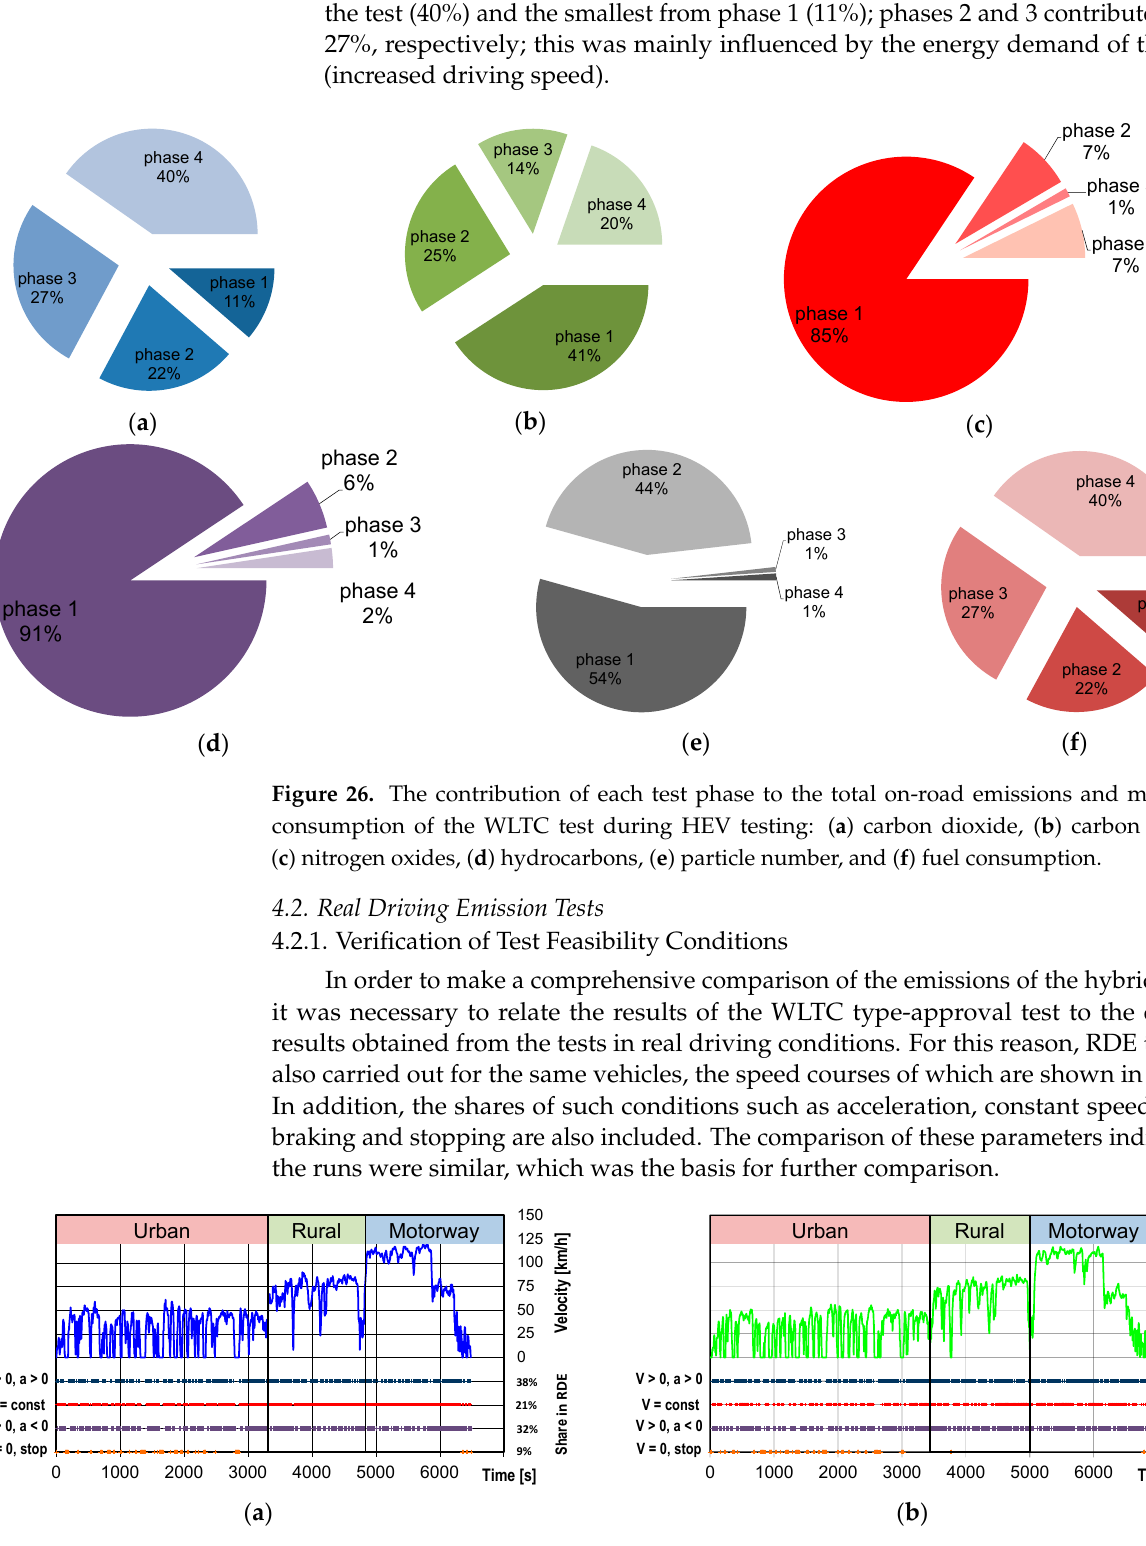
Figure 27. The scheduled velocity of vehicle during the real driving emissions test for: ( a ) plug-in; ( b ) HEV.